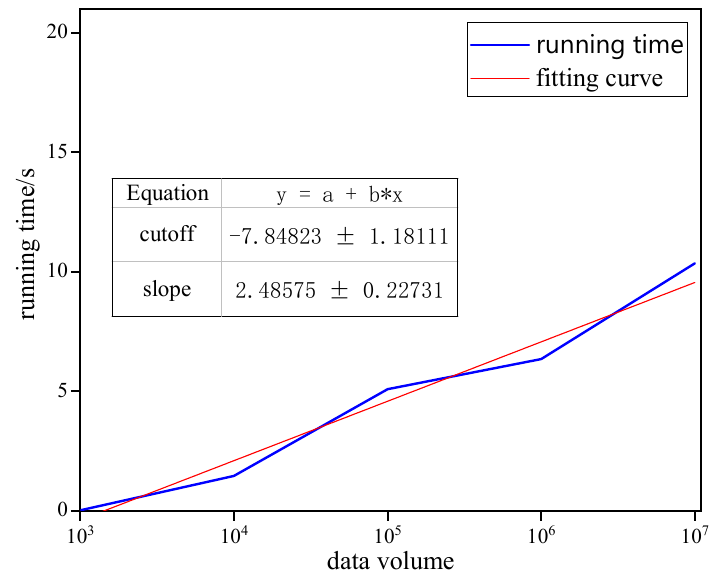
Figure 9. Efficiency assessment at different data volumes.